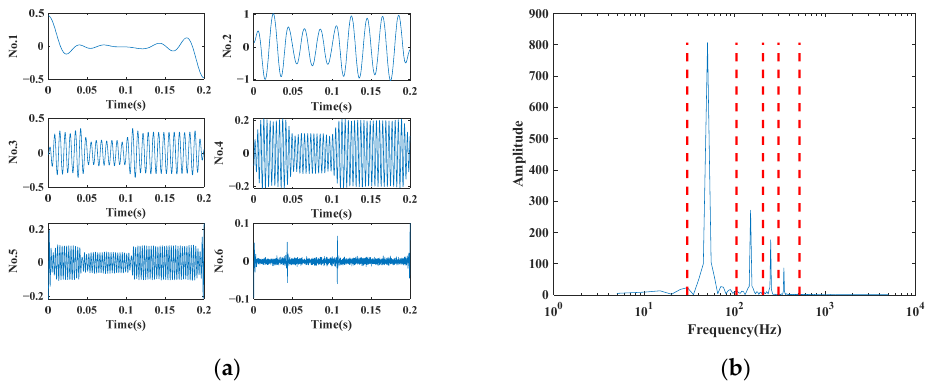
Figure 8. PQD signal decomposition results by EWT when K = 6. ( a ) Results in the time domain; ( b ) Segmented spectrum.